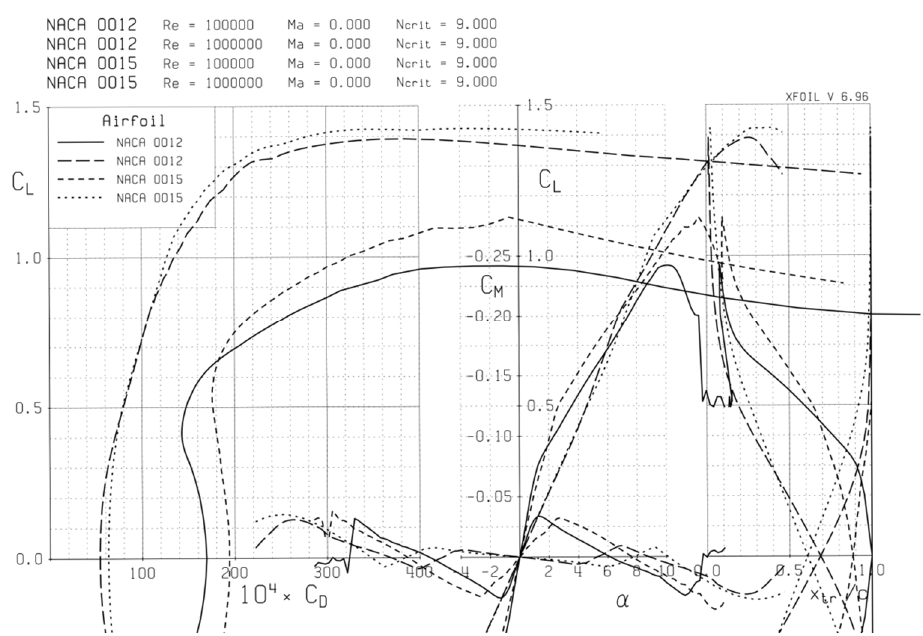
Figure 3. Two-dimensional ( 2D) polars for NACA 0012 and NACA 0015 free transition.